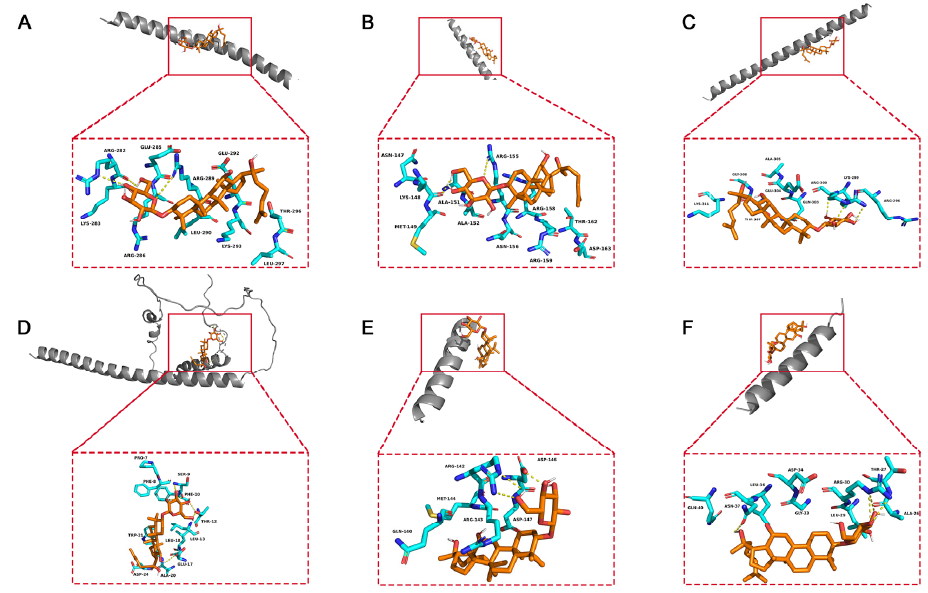
Figure 10. Molecular docking models of G-Rh2 and ( A ) JUN, ( B ) FOS, ( C ) ATF4, ( D ) DDIT3, ( E ) BBC3, and ( F ) PMAIP1. 20(S)-GRh2, 20(S)-ginsenoside Table 2. Molecular docking results.